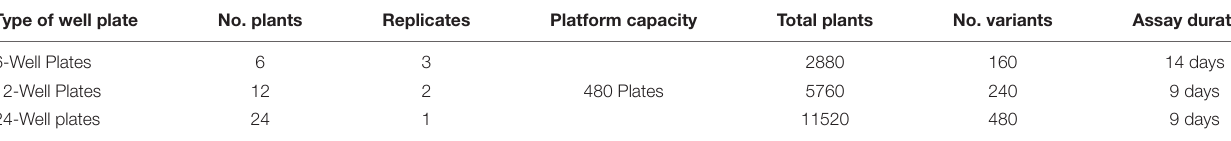
FIGURE 11 | Natural variation in Arabidopsis rosette growth in different MS media with salt. (A) Green area (pixels) of 4 DAG Arabidopsis seedlings grown in 12-well plates ( n = 36) with different MS media and 75 mM NaCl for 9 days. Mean ± SE . The equations of the curves and the Pearson’s correlation coefficients with significance according to ANOVA after linearization were calculated. ∗∗∗ p < 0.001. (B) Relative growth ratio (RGR, pixel pixel − 1 day − 1 ) of 4 DAG Arabidopsis seedlings grown under the same conditions. (C) Comparison among 11 DAG Arabidopsis seedlings grown in different MS media with or without 75 mM NaCl. (D) Comparison among 13 DAG Arabidopsis seedlings grown in different MS media with or without 75 mM NaCl. TABLE 4 | The capacity of the high-throughput in vitro Arabidopsis bioassay using different well plates. Type of well plate No. plants Replicates Platform capacity Total plants No. variants Assay